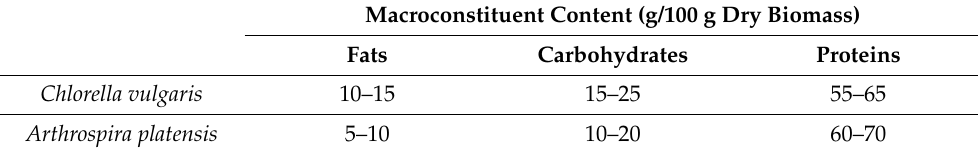
Table 1. The main macroconstituent content from tested microalgae biomass [33–36].